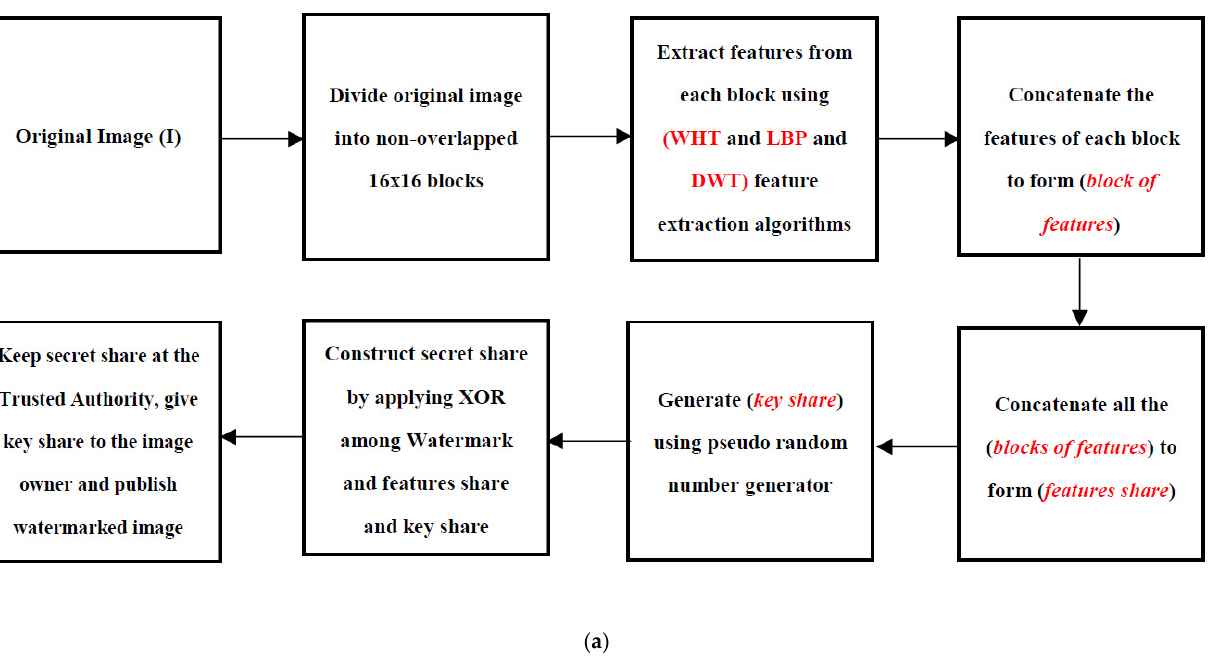
( b ) Figure 4. Block diagram of the proposed method: ( a ) Shares construction phase; ( b ) Image forgery verification.